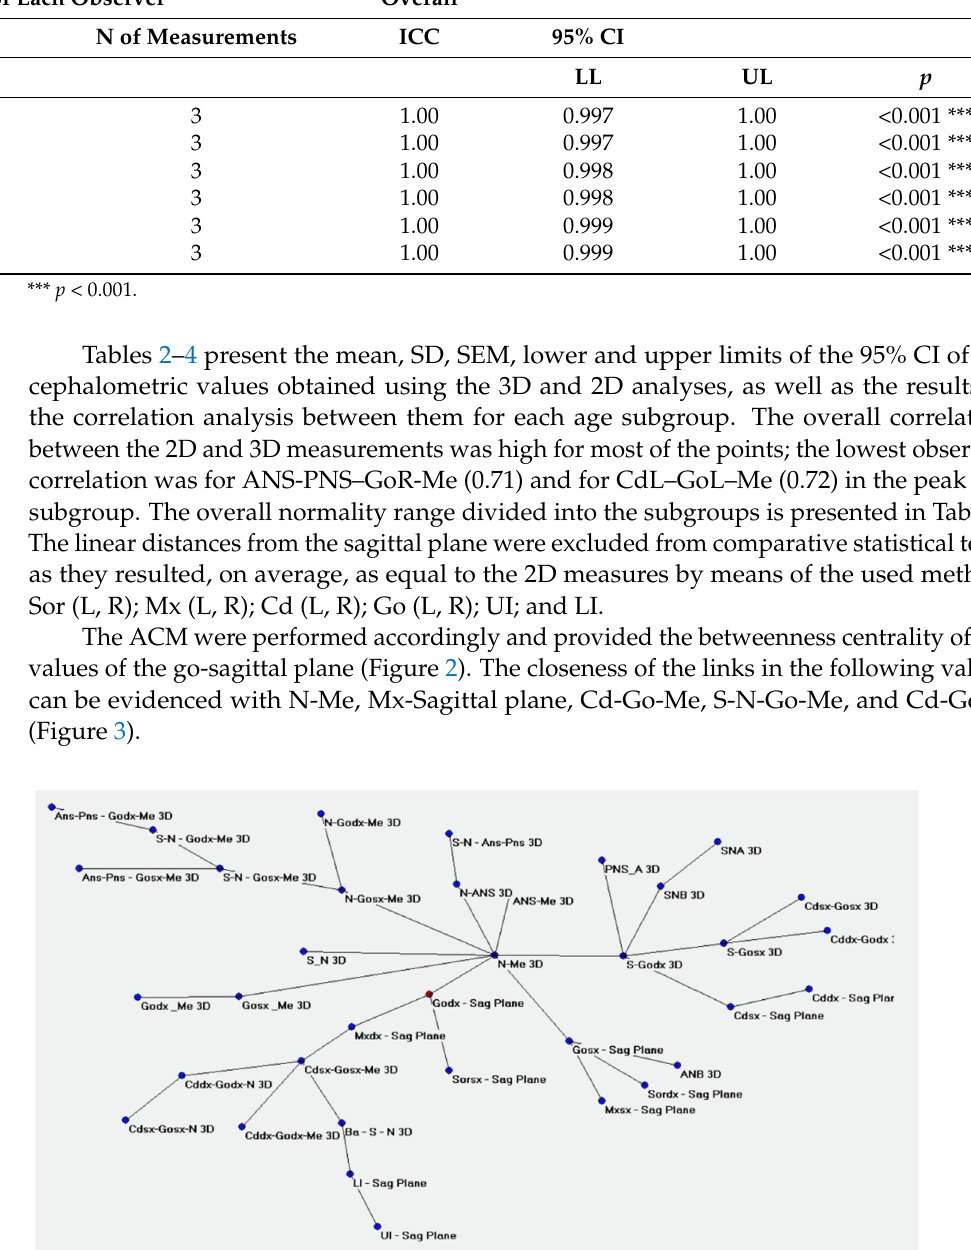
Figure 3. Betweenness centrality displayed on Pajek, calculated with Auto Contractive Maps. 4. Discussion A conventional 2D cephalometric analysis using lateral and frontal cephalograms, along with facial scanning, is currently the main diagnostic imaging modality used for orthodontic diagnosis and treatment planning [17,18]. The main disadvantages of the 2D conventional cephalometry are represented by projective displacement, rotational errors, and linear projective transformation, which might affect the reliability and reproducibility of the relevant measurements [19]. In addition, the 2D measurements could be distorted in patients presenting facial asymmetries who need a proper anterio-posterior cephalom- etry for their treatment plan. However, despite some limitations, conventional cephalometry still represents the golden standard, especially when in the presence of latero-cephalometric radiographs in children and airway monitoring [20]. Some addi- tional information could be obtained, together with asymmetries and jaw width; instead, it is difficult to evaluate the skeletal harmony based on the skull width and length in the lateral view [21]. Frontal cephalometries are subject to inter-operator variations, as many structures are superimposed, making it difficult to accurately identify landmarks and measure- ments. This problem can be overcome by using CBCT, as the structures can be identified